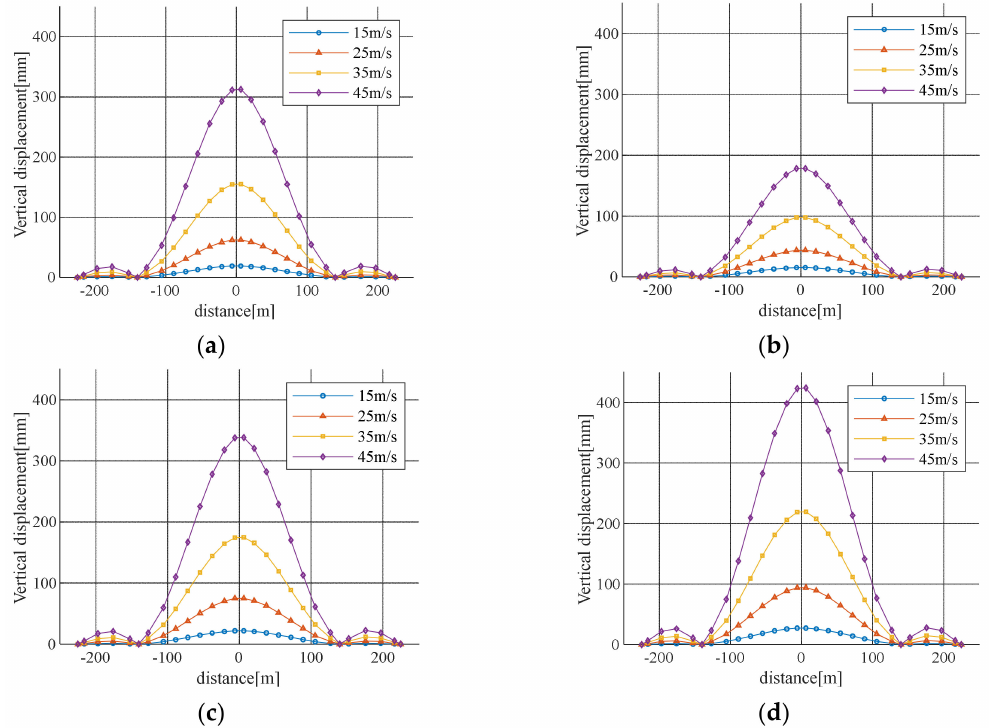
Figure 8. Analytical vertical bending responses at the bridge deck: ( a ) Case I; ( b ) Case II; ( c ) Case III; ( d ) Case IV.